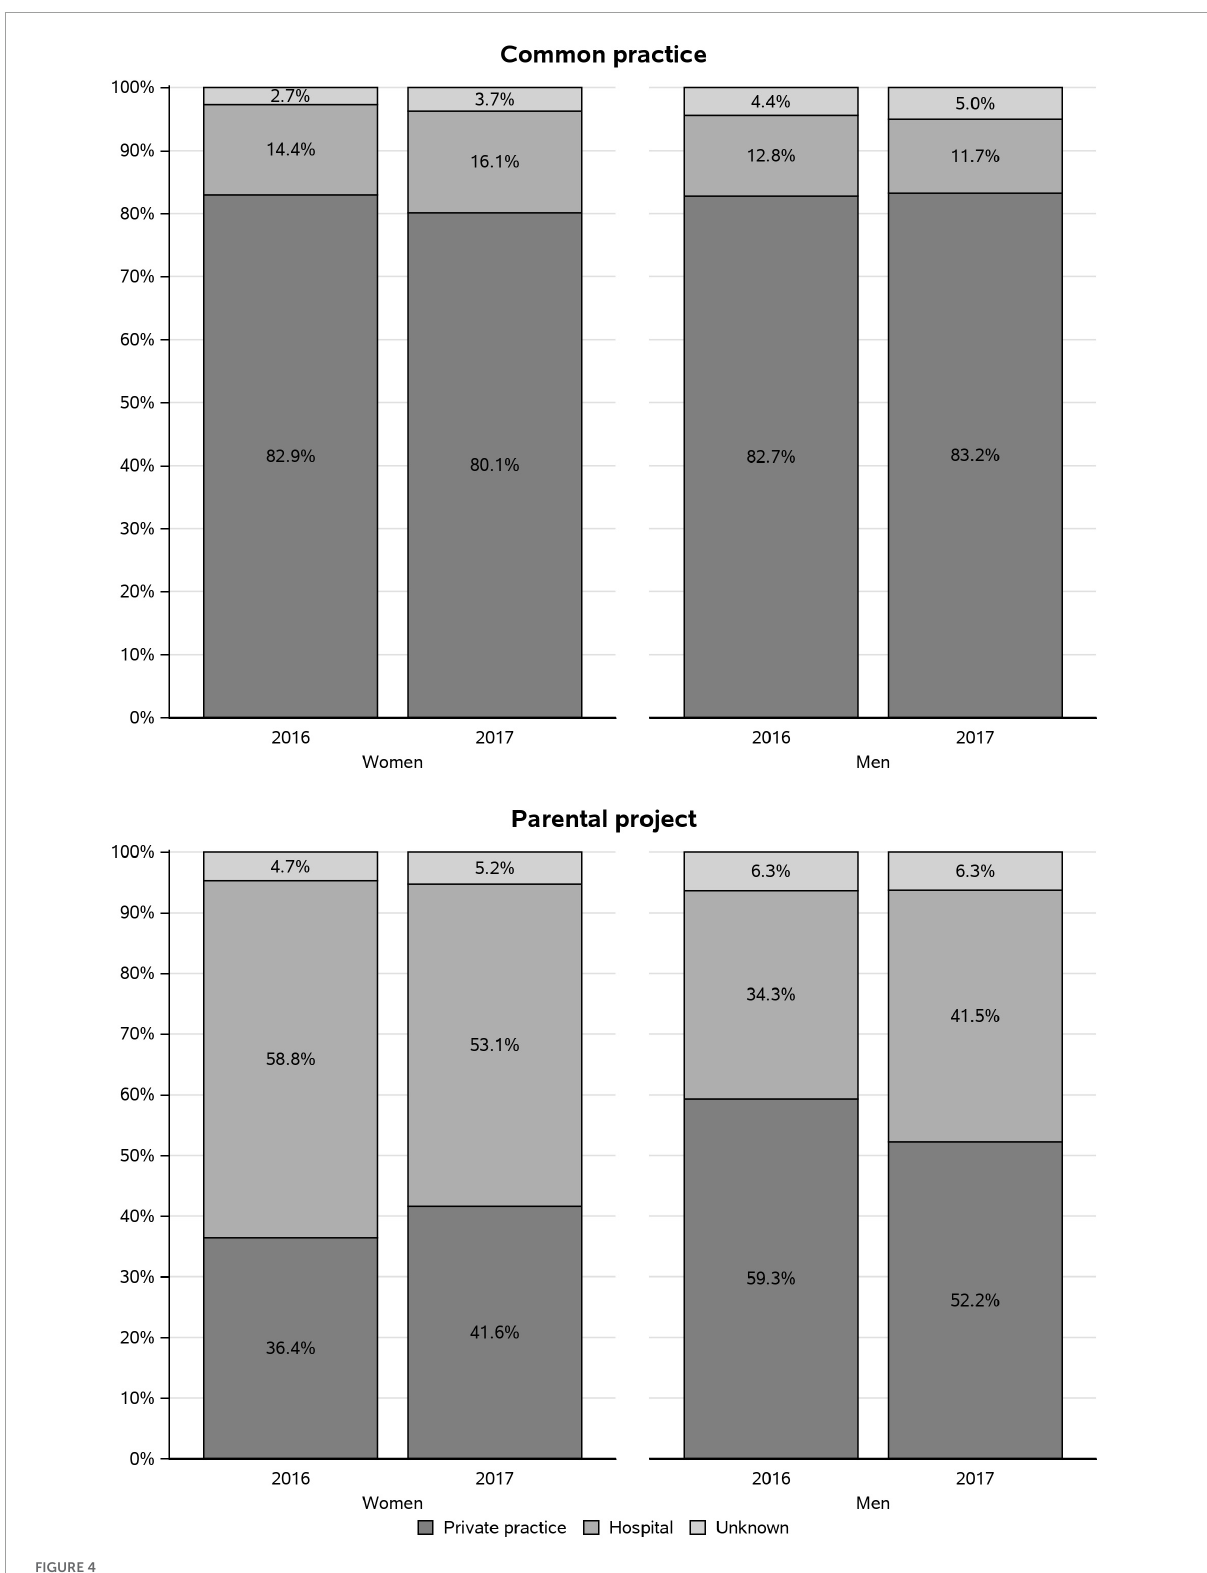
FIGURE4 Private or hospital practice setting of the healthcare professional (HCP) who prescribed the pertussis vaccine in 2016 and 2017, according to the study period.